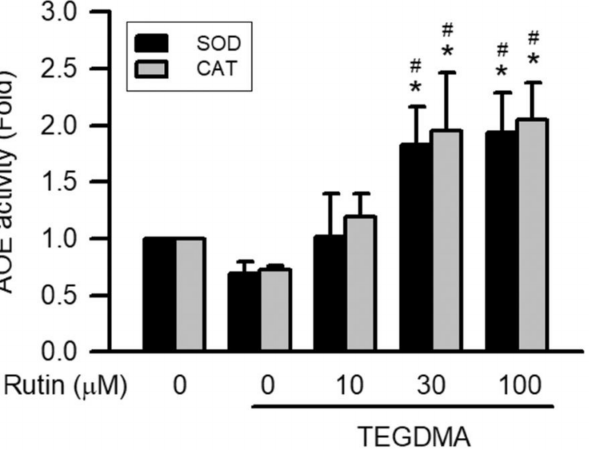
Figure 6. Effect of rutin on TEGDMA-reduced AOE activities in RAW264.7 macrophages. Values are expressed as mean ± S.D. of three times per group. * Represents significant difference between the indicated and control groups, p < 0.05. # Means significant difference between the indicated and TEGDMA groups, p < 0.05.